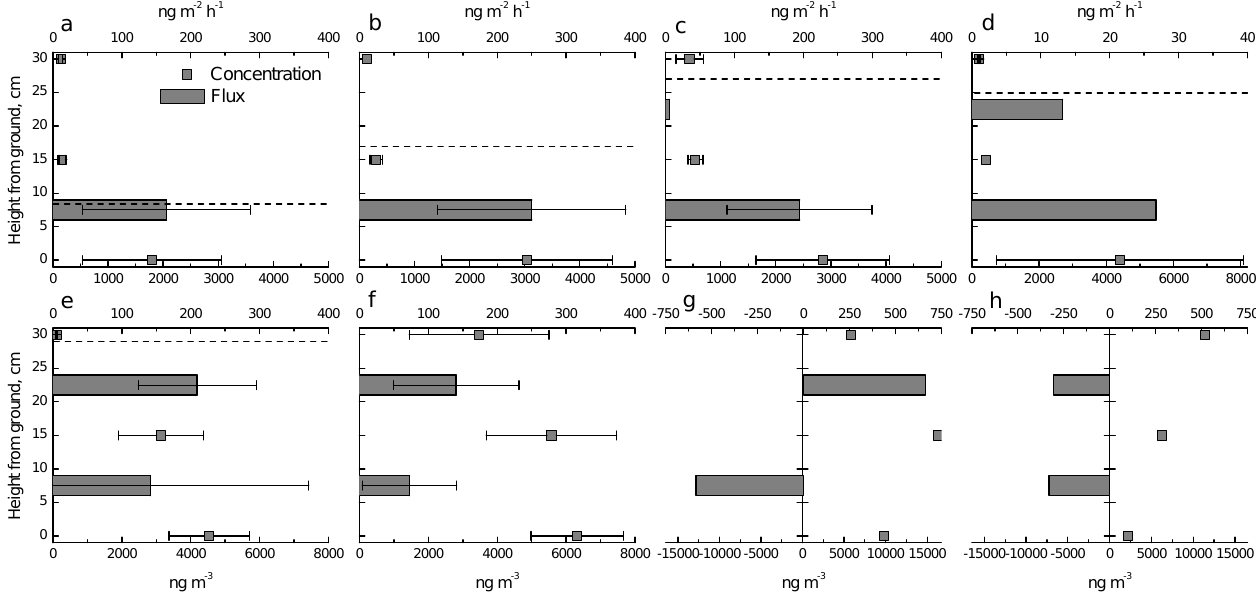
Fig. 3. Total monoterpene concentrations and estimated fluxes in the snowpack during sampling dates (a) 27 November 2008, (b) 5 Febru- bars (if more than two values) represent standard error of the tree collectors. 0cm represents the soil surface and dashed horizontal line the snowpack depth, if it was below 30cm. Data of two damaged profiles were omitted from sampling days 2 February 2010 and 1 March